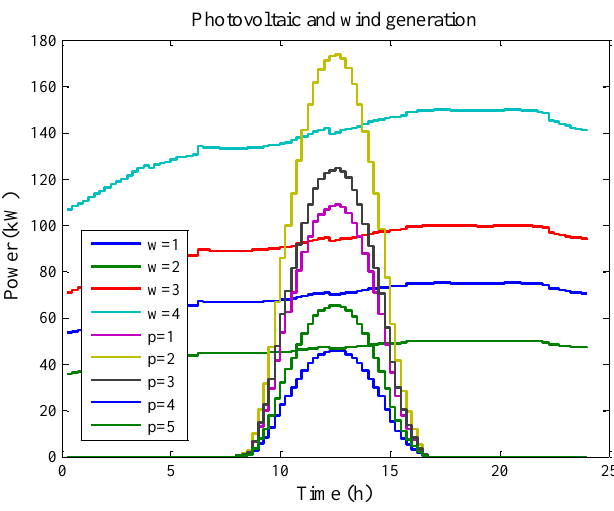
Figure 24. Power demand time series (Case study 3).